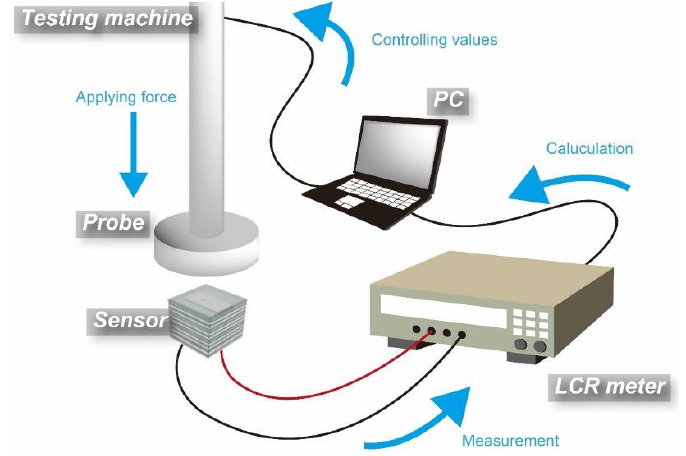
Figure 6. Experimental setup for measurement of parasitic capacitance.